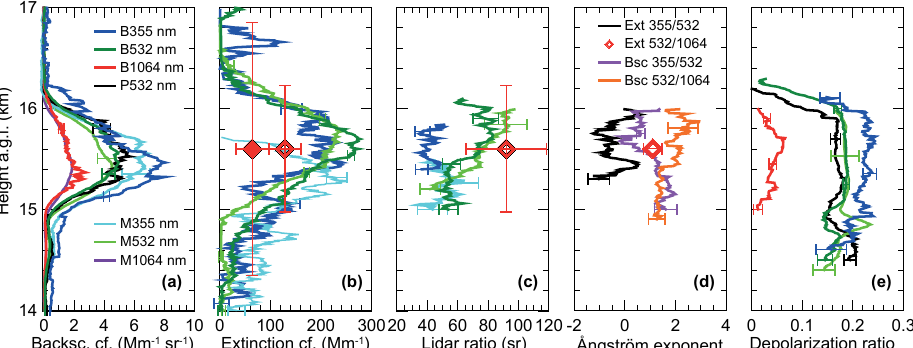
Figure 3. Same as Fig. 2, except for the stratospheric aerosol layer and for different signal smoothing lengths (as explained in Sect. 2.2). In the case of the 1064nm extinction coefficient (red solid diamond), a retrieval window length (least-squares method) of 2500m had to be applied (indicated by the long vertical bar). We estimated the layer-mean 1064nm extinction coefficient (red open diamond) for the 1250m thick layer from 15 to 16.25km by multiplying the obtained value for the 2500 window length by a factor of 2 (see text for more details). In the subsequent calculation of the 1064nm lidar ratio, we used this 1250m layer-mean extinction value (open diamond) together with an appropriately smoothed backscatter coefficient (see text for more details). The most surprising finding is the strong difference between the tropospheric (Fig. 2e) and stratospheric (e) smoke depolarization ratios at 355 and